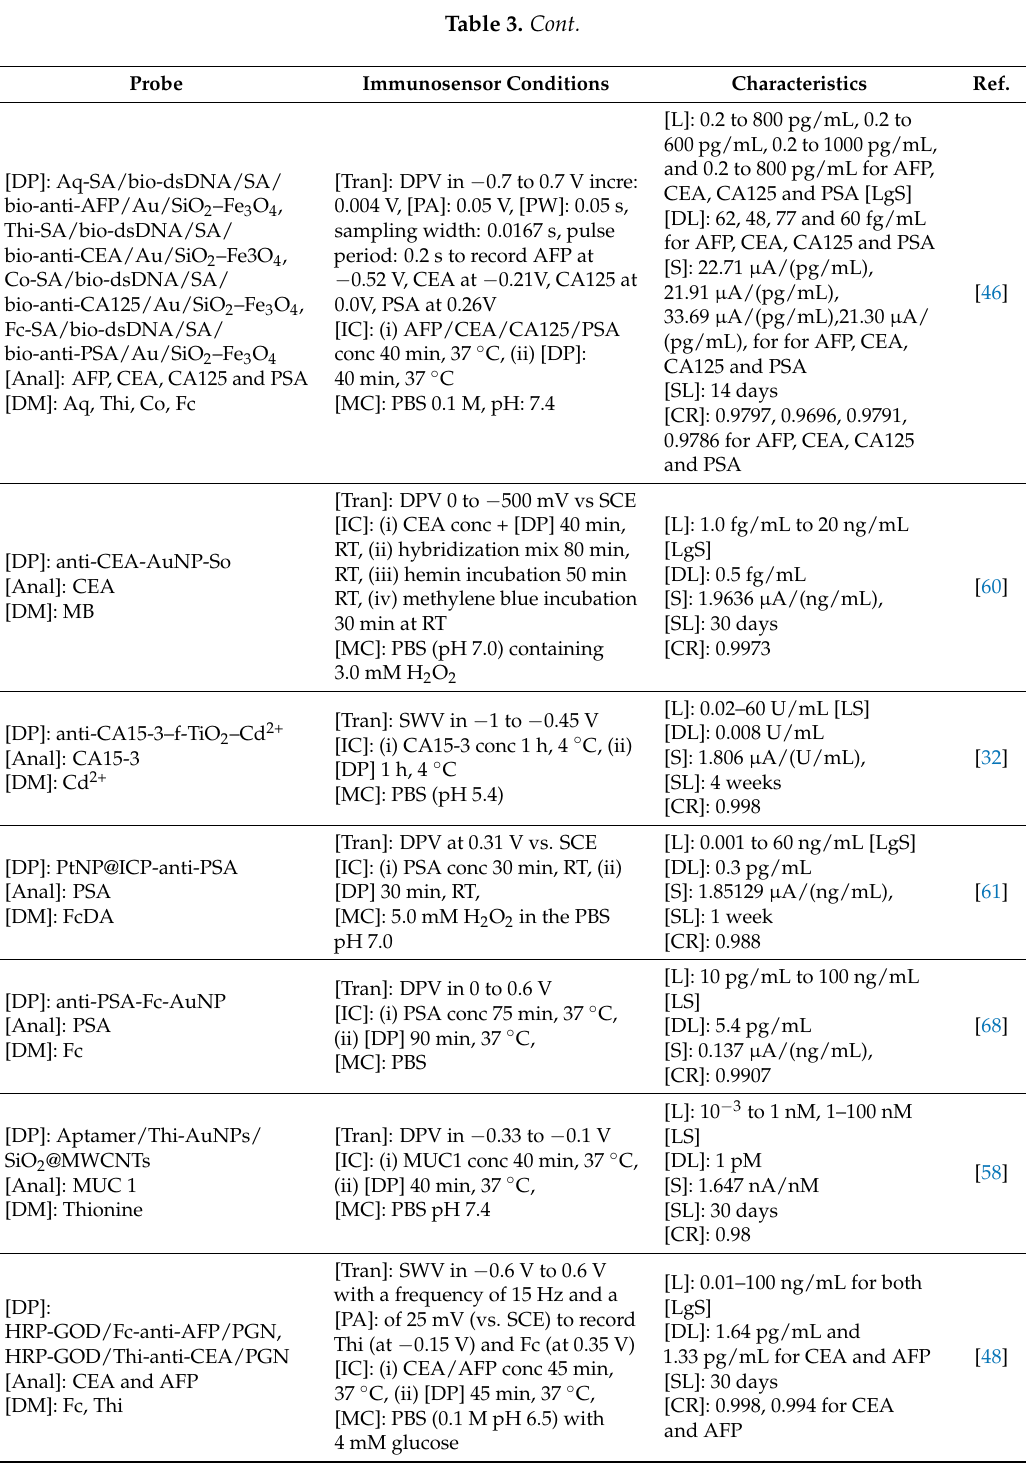
Probe Immunosensor Conditions Characteristics